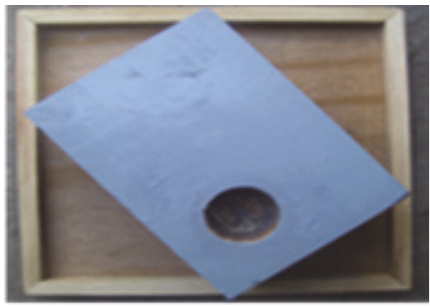
Figure 3: Output of canny edge